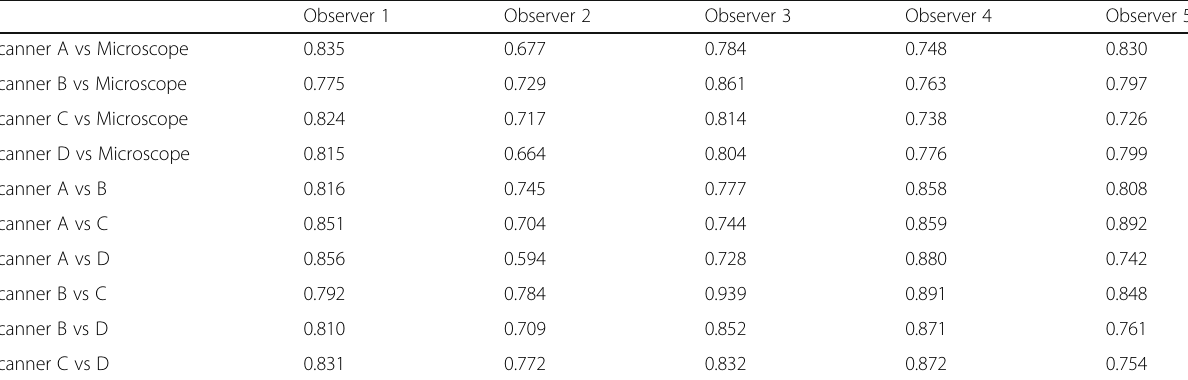
Table 3 Intra-observer agreement in each observation method (Kappa coefficient) Observer 1